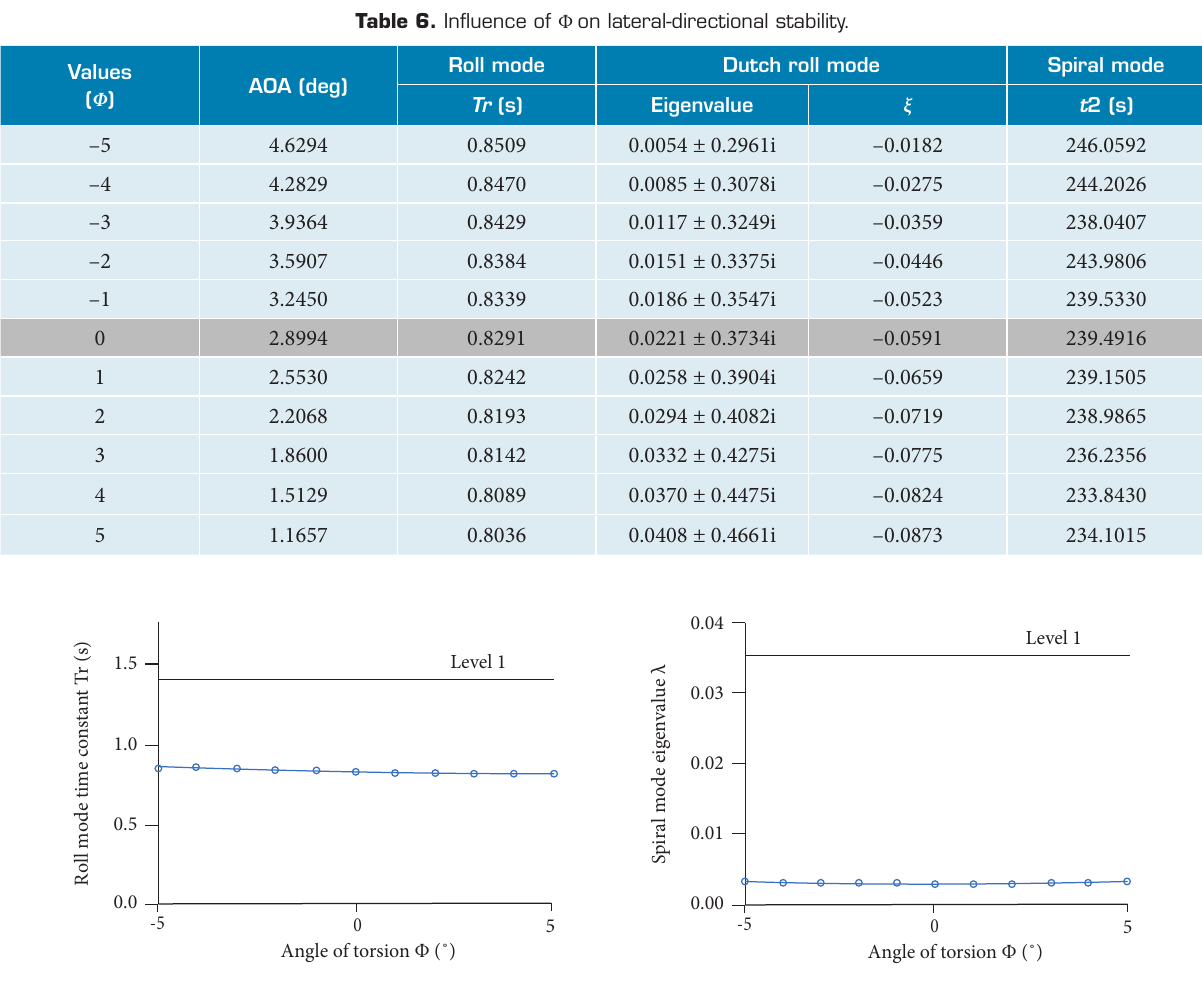
Figure 7. Influence of Φ on roll mode and spiral